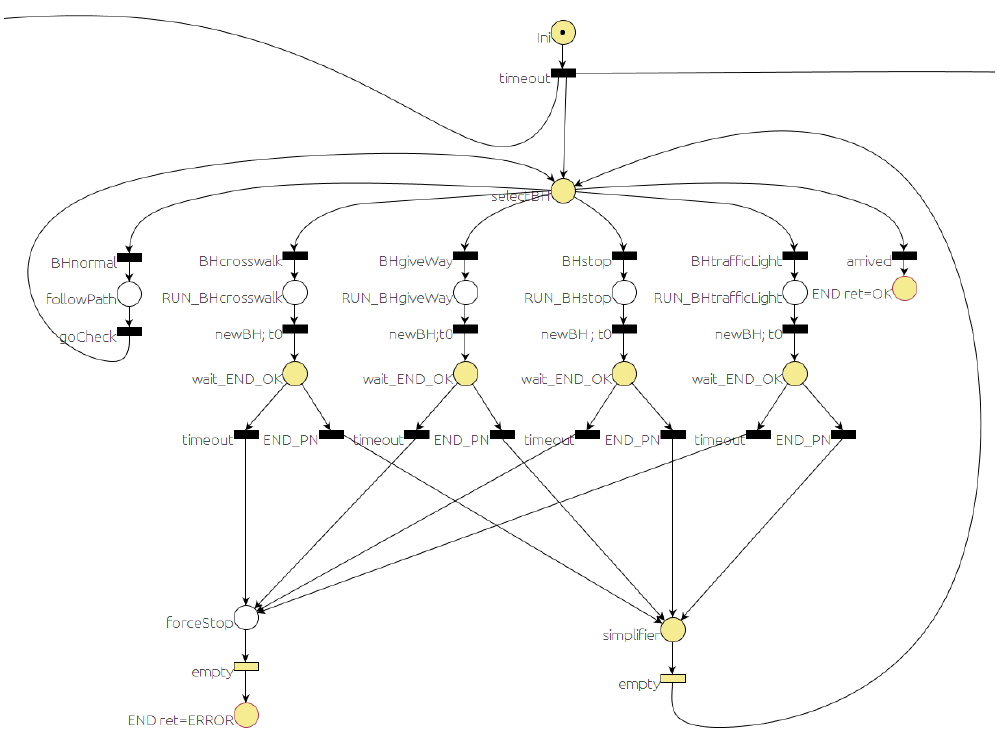
Figure 5. Selector PN: the behavior execution